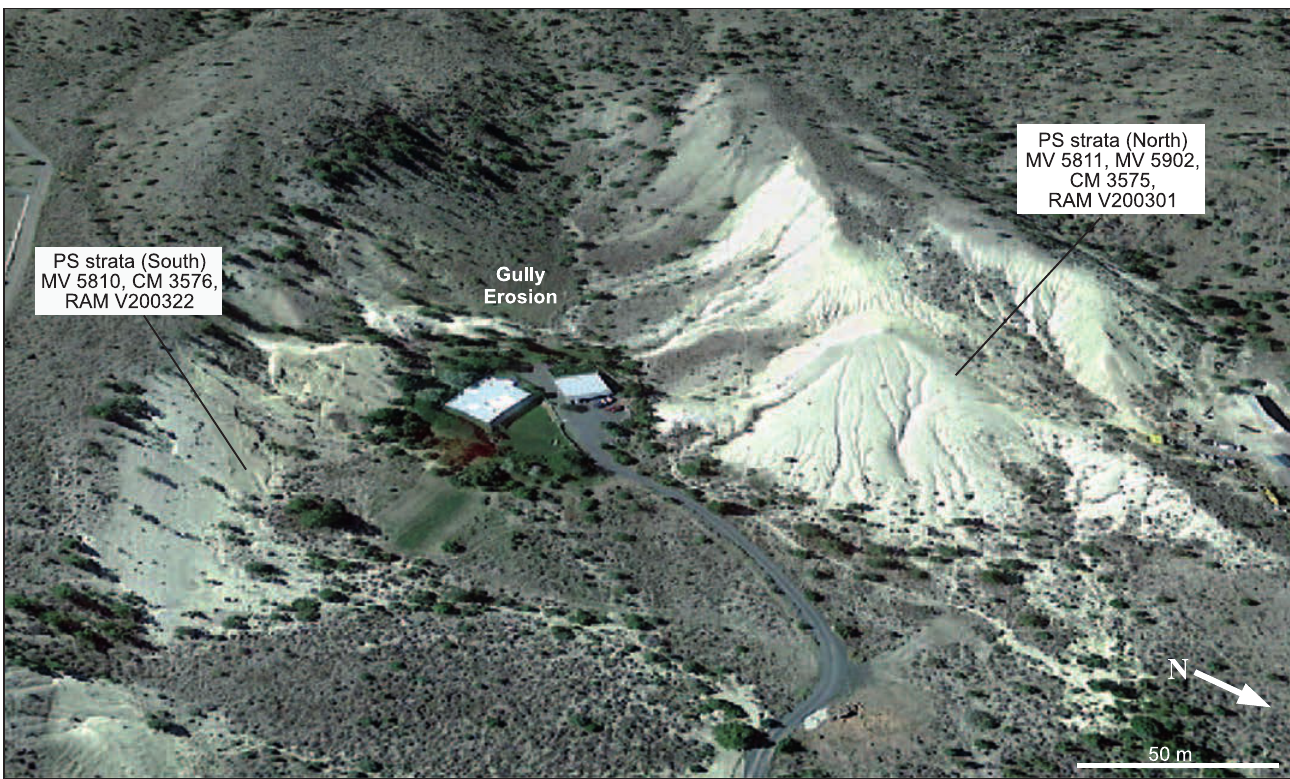
Fig. 3. Overview of the Pipestone Springs area, southwest Montana (from Google Earth 7.3.3.7786, July 21, 2020, Pipestone Springs, Montana, 45°53’42.79”N, 112°15’42.00”W, Eye altitude 5264 feet. Digital Globe 2012. http://www.earth.google.com [September 19. 2020]). Pipestone Springs (PS) strata occur in both a south and north area, separated by a 100 m-wide gully. Because of this geographic separation, vertebrate fossils from the two areas have been curated separately. Abbreviations: MV, University of Montana vertebrate locality; CM, Carnegie Museum of Natural History locality; RAM, Raymond M. Alf Museum of Paleontology